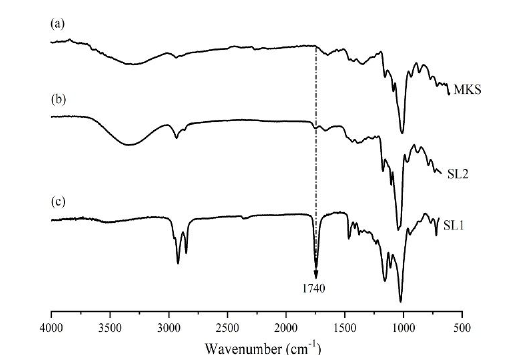
Figure 2. Infrared spectra of MKS (a), SL2 (b) and SL1 (c).